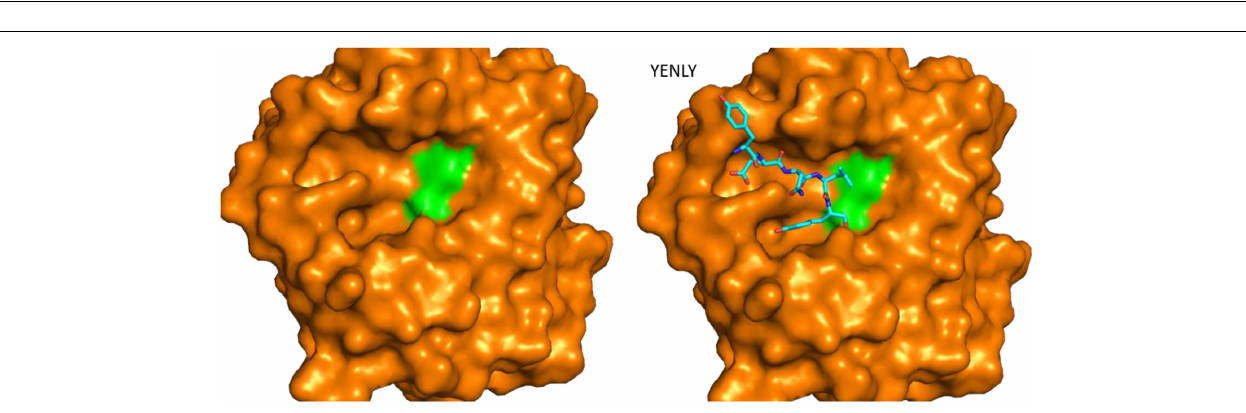
FIGURE 3 | Crystal structures of microbial keratinases. The crystal structures of five keratinases were shown to understand their mechanism of action. The PDB access codes of the structures are indicated. The amino acids in active sites are highlighted in sticks and labeled with sequence numbers. Ca 2 + and Co 2 + atoms in the structures are shown as yellow and green spheres, respectively. In the crystal structure of fervidolyis (PDB:1R6V) (Kim et al., 2004), His208 was mutated into Ala. Ala 208 was labeled as His208 in this figure to show the active site. The β -sheet structures in FisCP (PDB: 5E3X) are highlighted in blue (Lee et al., 2015). All the figures were made using PyMOL (www.pymol.org). The details of the structures can be found in the reports (Betzel et al., 2001; Kim et al., 2004; Teruo et al., 2015; Wu et al., 2017).